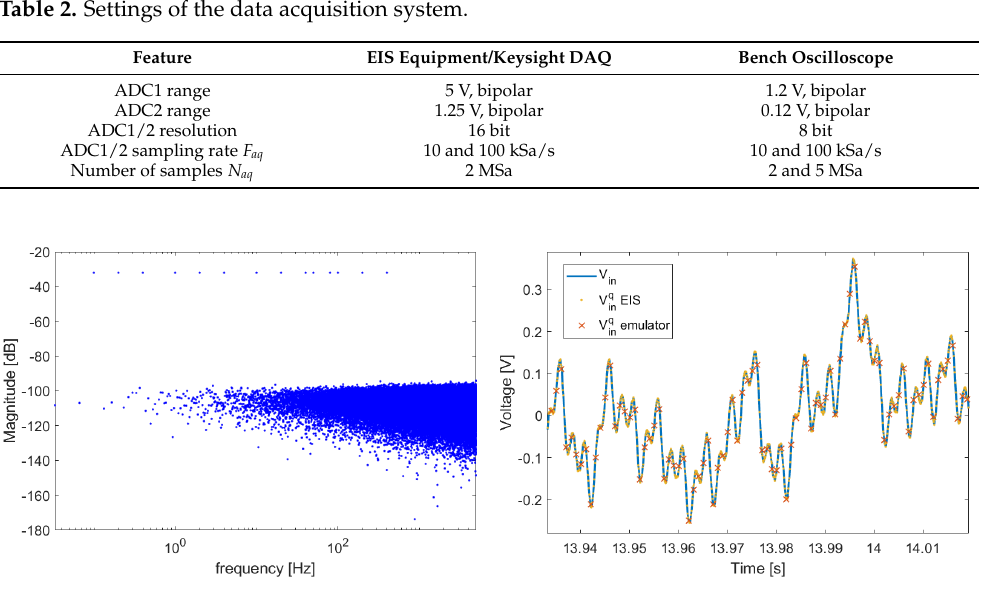
Figure 5. ( Left ): The power spectrum of the generated V in . ( Right ): A portion of V in in the time domain. The sampled and quantized sequences are renormalized for ADC ranges and levels, in order to be shown together with the original